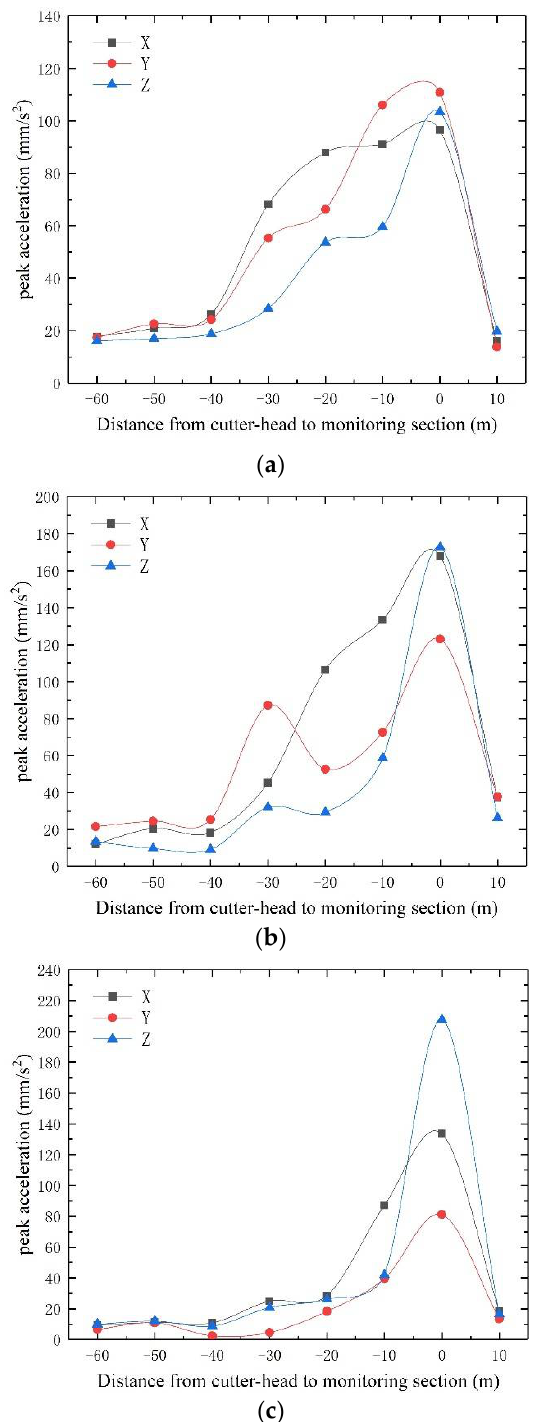
Figure 10. Longitudinal influence trend with different buried depths. ( a ) 0 m depth; ( b ) 10 m depth; ( c ) 20 m depth.